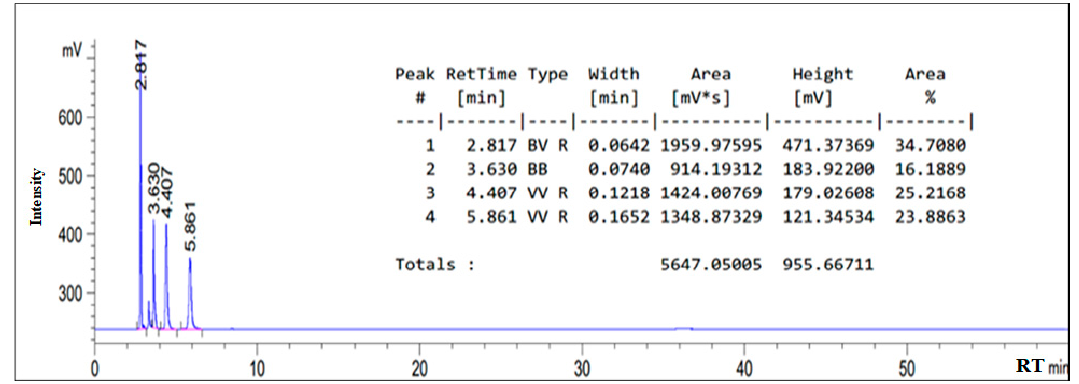
Figure 2. HPLC chromatogram for 0.5wt.% as-synthesized surfactant chromatogram. Table 3. Unwashed as ‐ synthesized surfactant composition and retention time. Composition